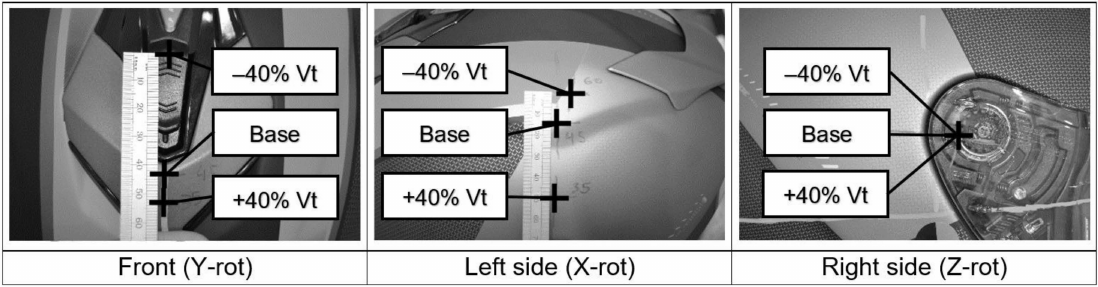
Figure A3. Impact point locations for each impact layout and tangential